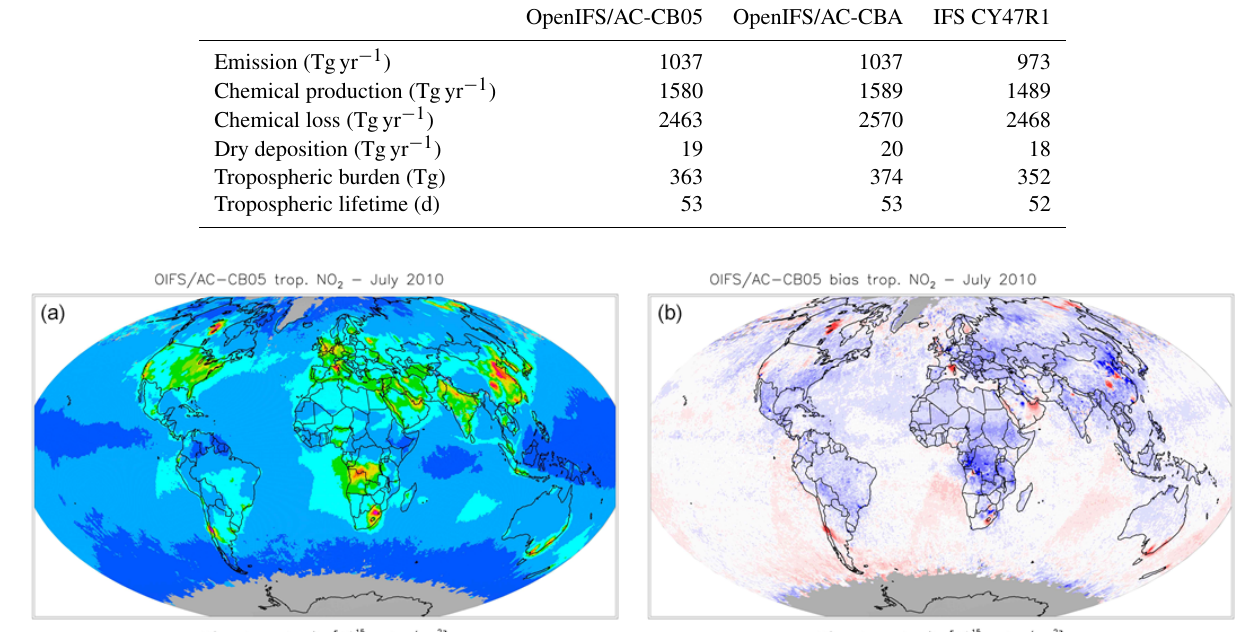
Table 6. Tropospheric carbon monoxide budget. Also included are results from IFS CY47R1 (Williams et al., 2021) for the year 2014, for reference.